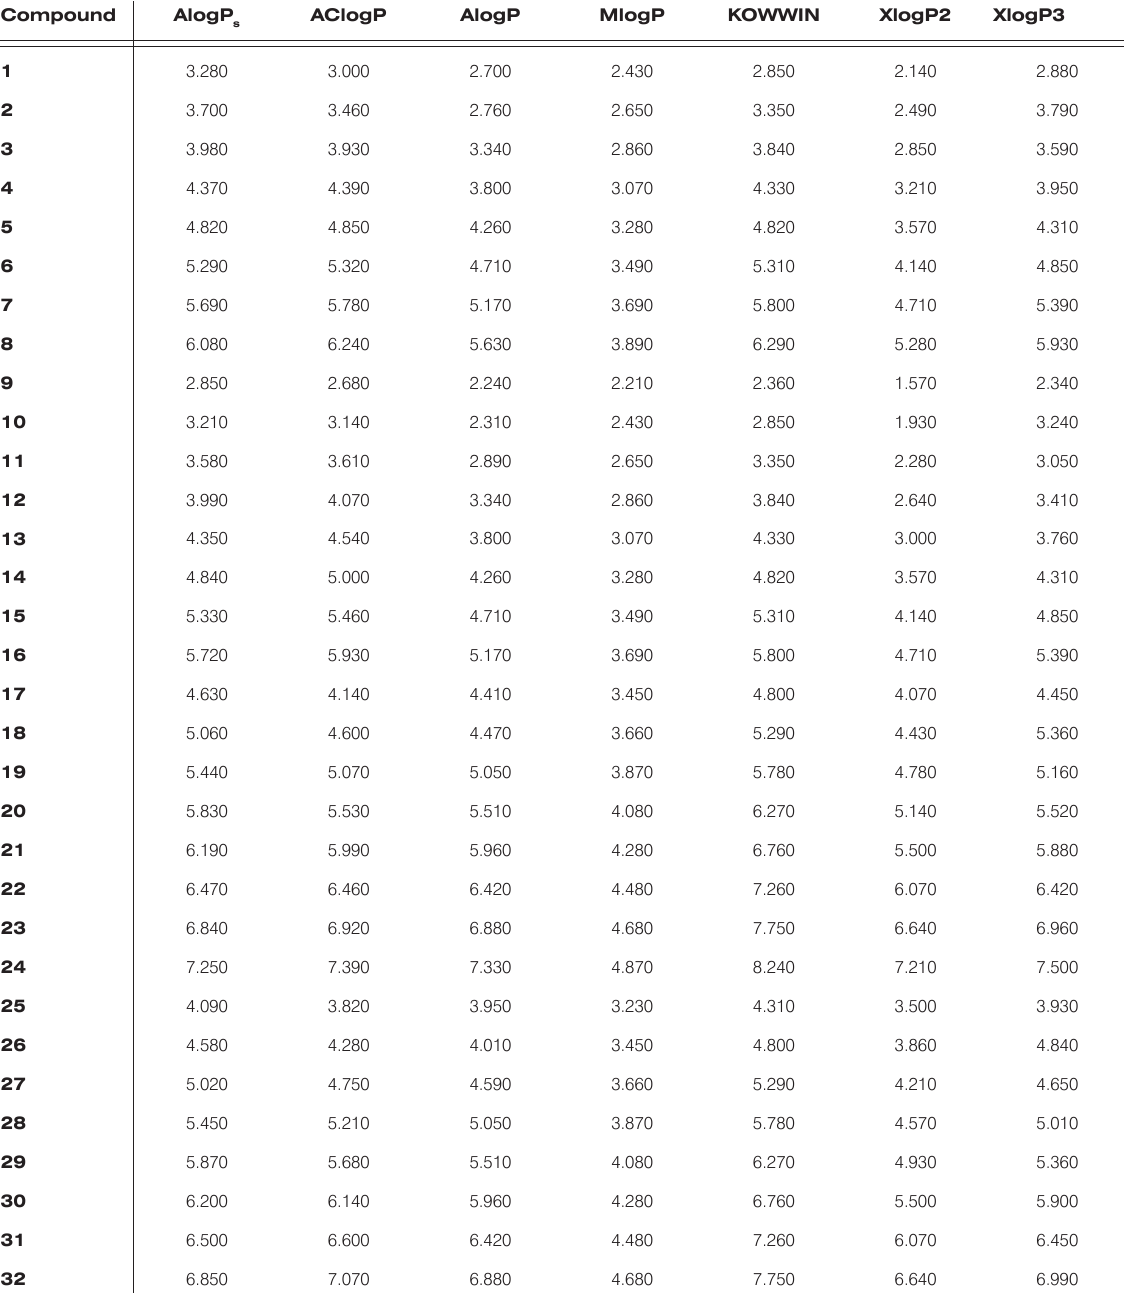
Table 4. Theoretical log P values obtained by the use of computational methods.